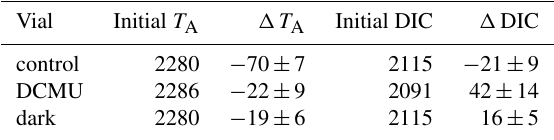
Table 2. Total alkalinity and DIC changes for every triplicate. Con- fidence interval: 1SD (taking biological variability into